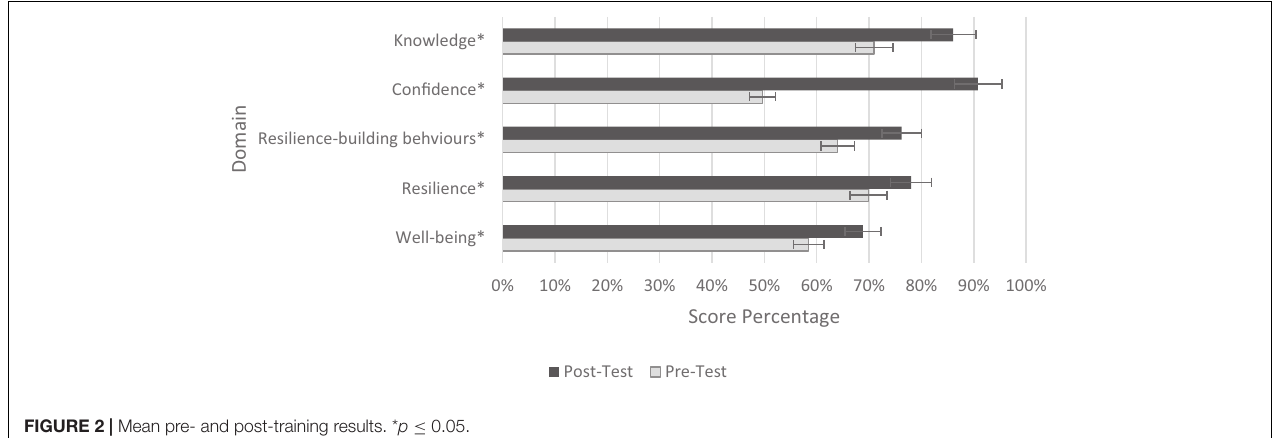
FIGURE 2 | Mean pre- and post-training results. * p ≤ 0.05. TABLE 2 | Changes in specific behaviours and socio-demographics predicting well-being or resilience (crude and multivariable analysis).